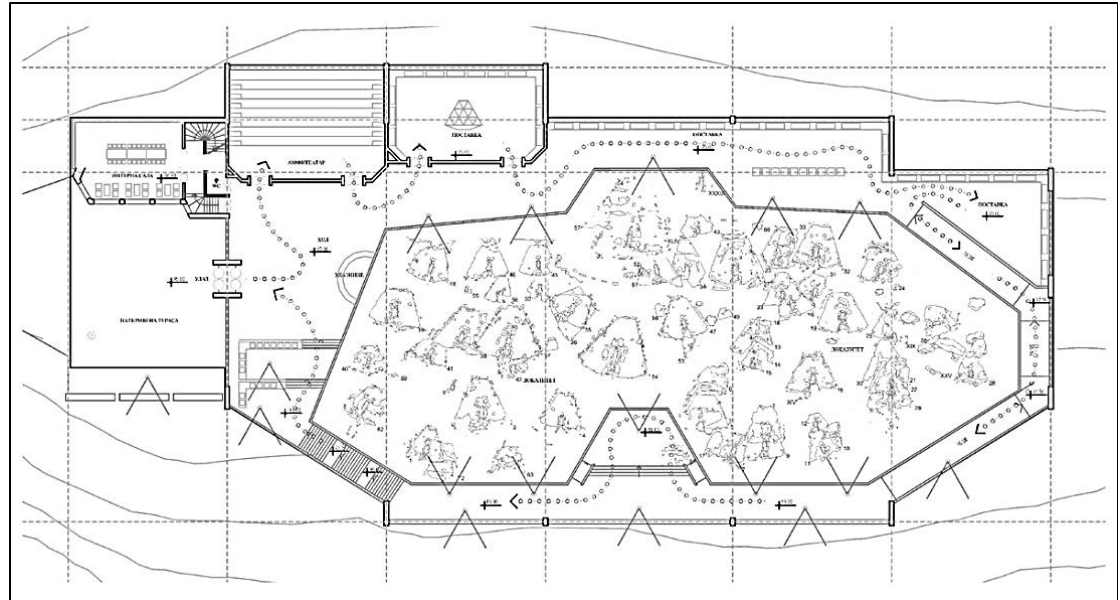
Figure 29. Terraced settlement and burial, now within the well-preserved remnants of Lepenski Vir, within the